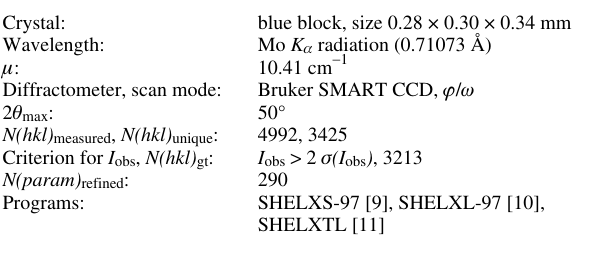
Table 1. Data collection and handling.